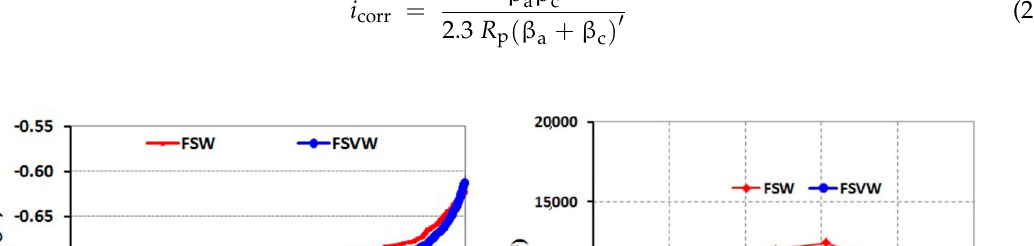
Figure 11. Force values measured during cutting process for different samples, and FS- and FSV- welded samples, as well as the base material.